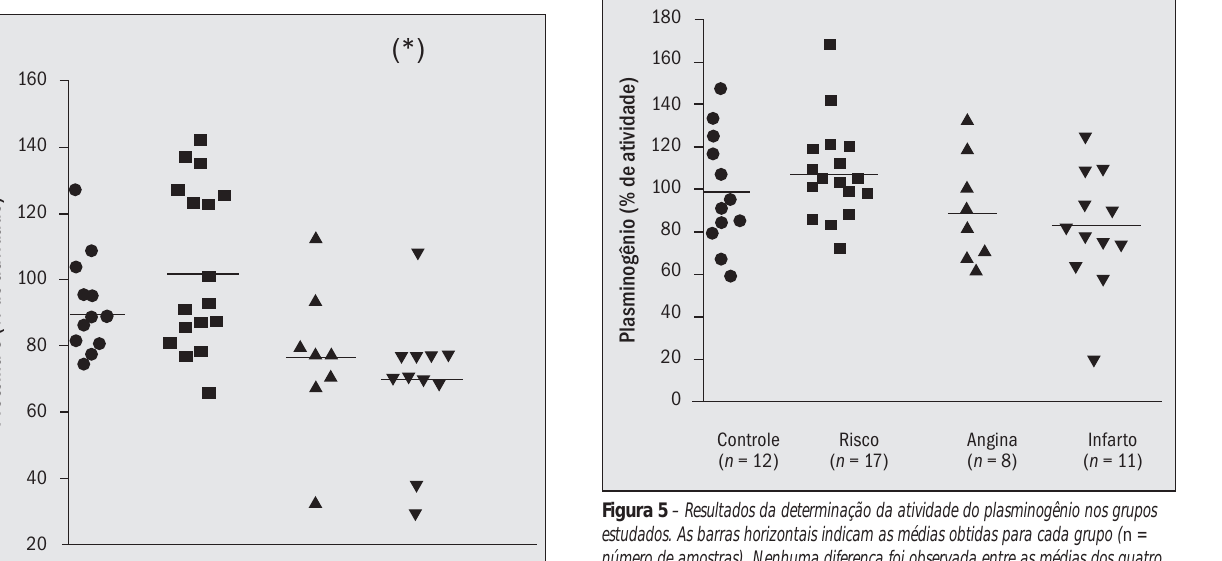
(PDF) nos grupos estudados. Não foi possível realizar a análise estatística devido à igualdade dos resultados for- necidos pelo grupo de risco. No entanto podem ser ob- servados alguns resultados bem mais elevados nos gru- pos com angina (um caso) e com infarto (dois casos).